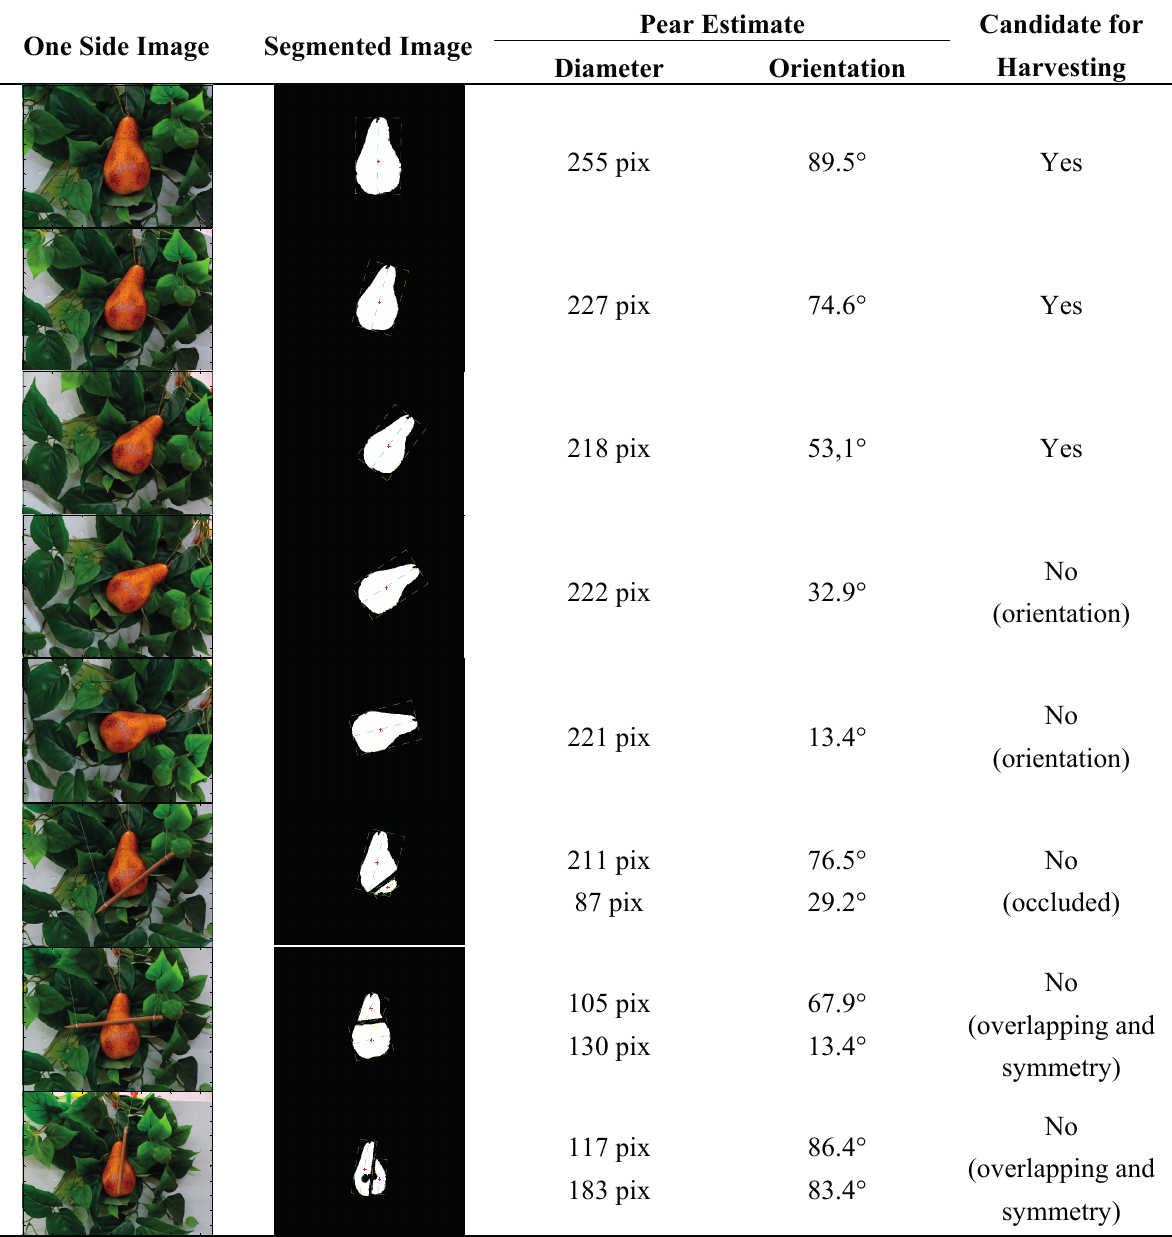
Table 9. Fruit detection: LCM segmentation [7]